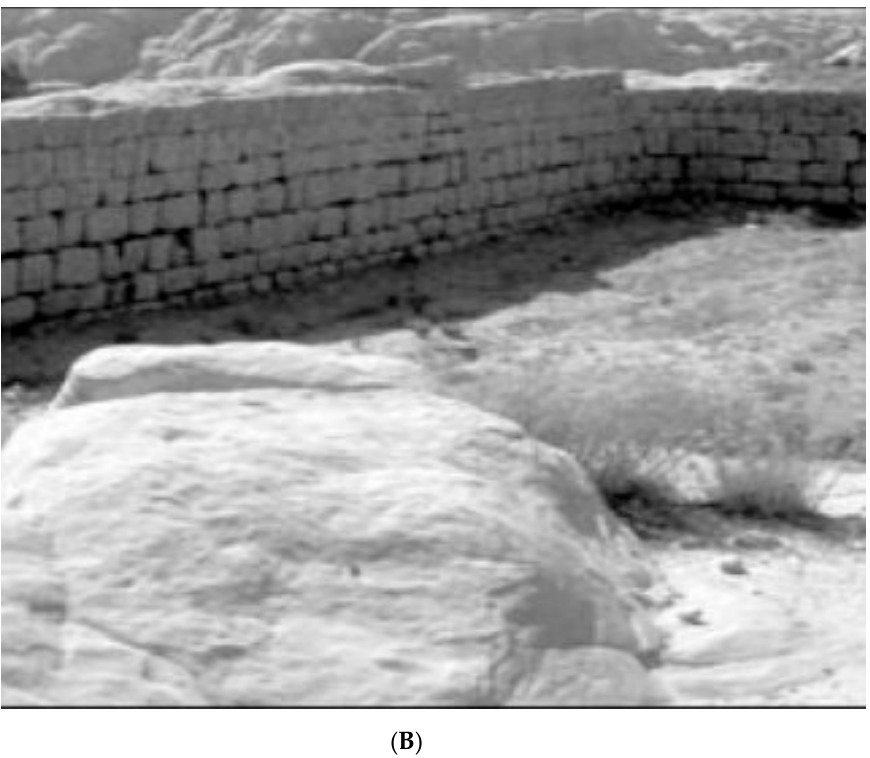
Figure 5. ( A ) Upper level Zurraba reservoir (Figure 1, 2D), ( B ) Lower-level M reservoir.